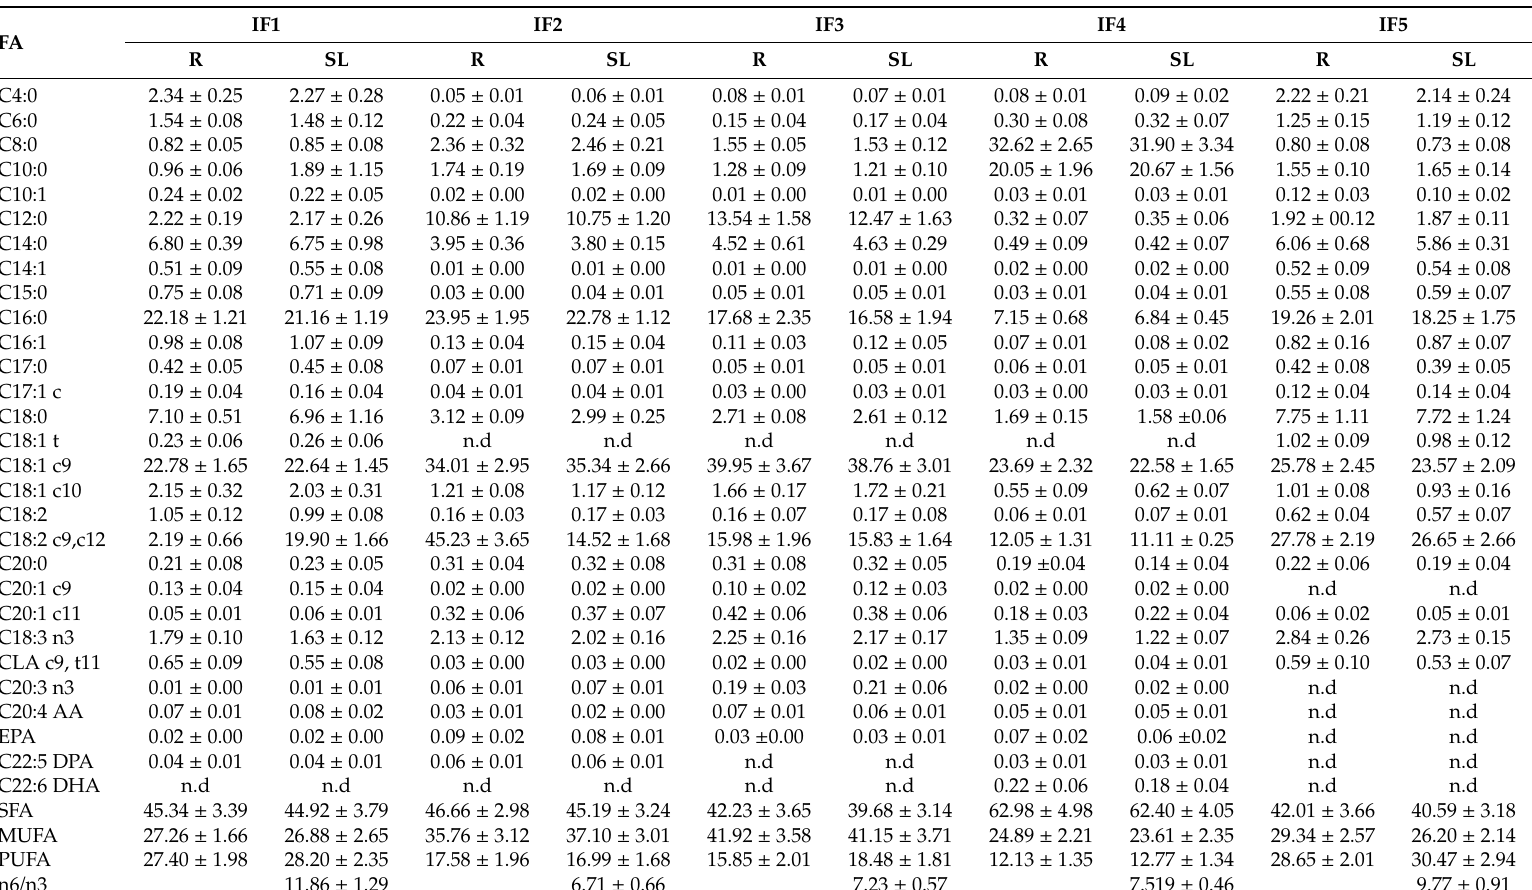
Table 1. Fatty acid composition (FA) (g FA / 100 g of total FA ± Standard Deviation (SD) at reception (R) and at the end of the shelf life (SL) in commercial infant formulas.